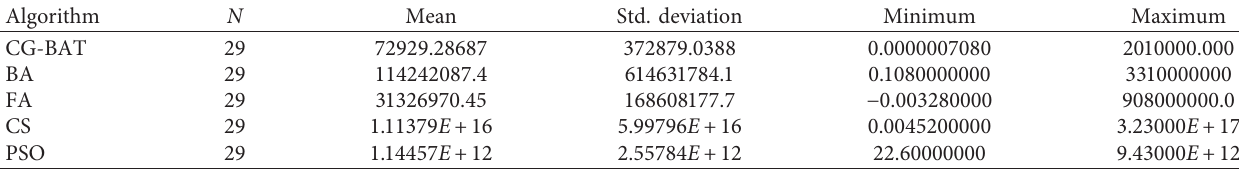
Table 5: Descriptive statistics for the five algorithms.